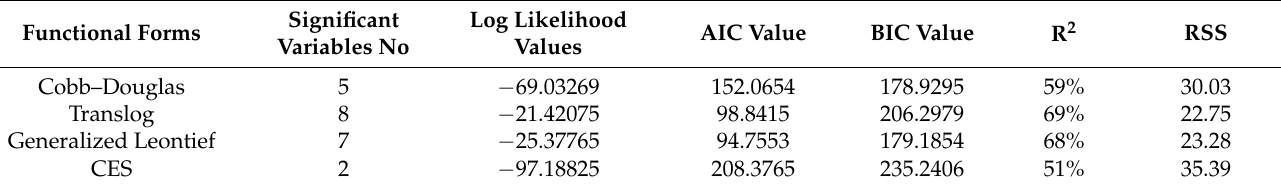
Table 1. Comparison of functional forms.